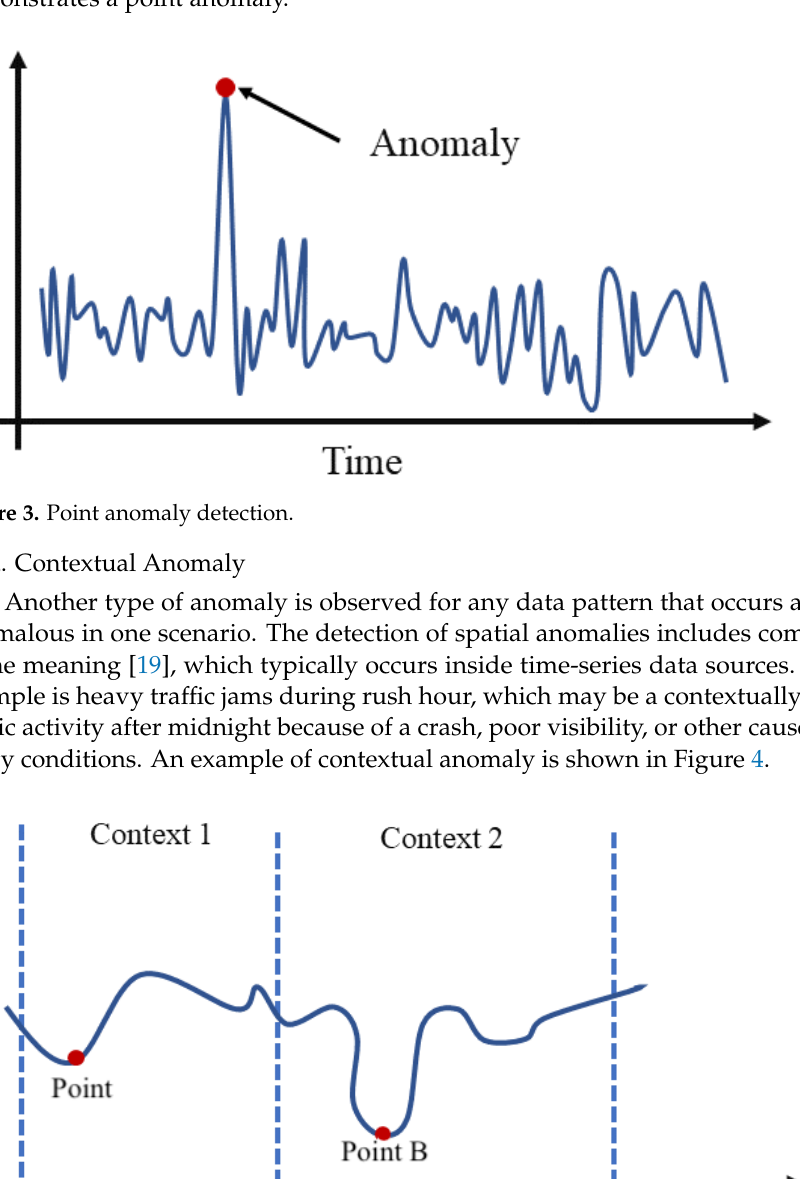
Figure 5. Collective anomaly for heart rate monitoring signal. 3.4. Anomaly Detection Learning Modes Anomaly detection learning modes can be classified into three types based on the availability of labels in the datasets used to create baselines [48], including supervised, semi-supervised, and unsupervised anomaly detection, as shown in Figure 6. Figure 6. IoT anomaly detection learning modes.